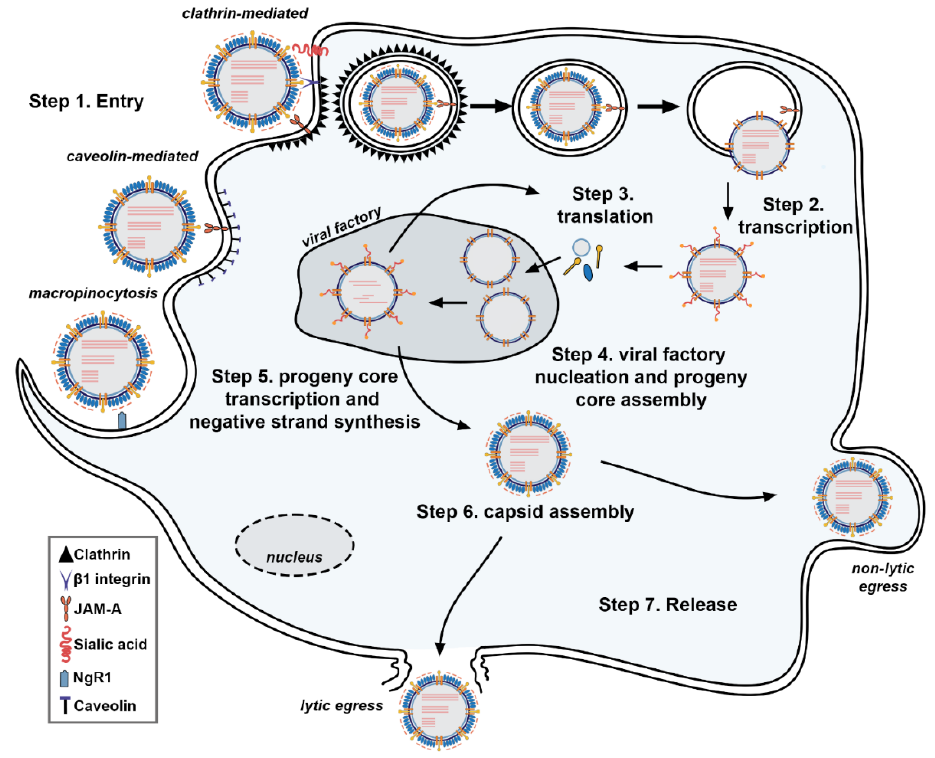
Figure 2. Reovirus Life Cycle. ReoV enters cells (Step 1) following binding of σ 1 protein to host cell receptor, such as JAM-A and, in some cases, sialic acids. Clathrin-mediated endocytosis is the most common entry mechanism, although caveolin-mediated endocytosis and macropinocytosis is also possible. The virions are then shuttled within endosomes. Proteolysis degrades the outer σ 3 protein and cleavage of the unveiled μ 1C into fragments δ and φ , leading to formation of the ISVP. The μ 1C cleavage fragments, along with μ 1N, form pores within the endosomal membrane, depositing the viral core now lacking both μ 1 and σ 1. Transcription by the RdRp λ 3 occurs within the viral core underneath channels formed by λ 2 (Step 2). Capping of mRNA is mediated by λ 2. Viral mRNA is exported from the viral core and into the cytoplasm, where translation occurs (Step 3). Viral proteins mediate nucleation of viral factories, where progeny cores begin to self-assemble (Step 4). Negative strand synthesis occurs within progeny cores, forming nascent viral genomes (Step 5). Progeny core transcription occurs, and outer capsid proteins begin to assemble around progeny cores (Step 6). Finally, progeny virons leave the cell, either via lytic or non-lytic egress (Step 7). ReoV initiates infection by binding to sialylated glycans on the host cell, employing its outer capsid protein σ 1 for this purpose. A-2,3, α -2,6, or α -2,8 linked sialylated